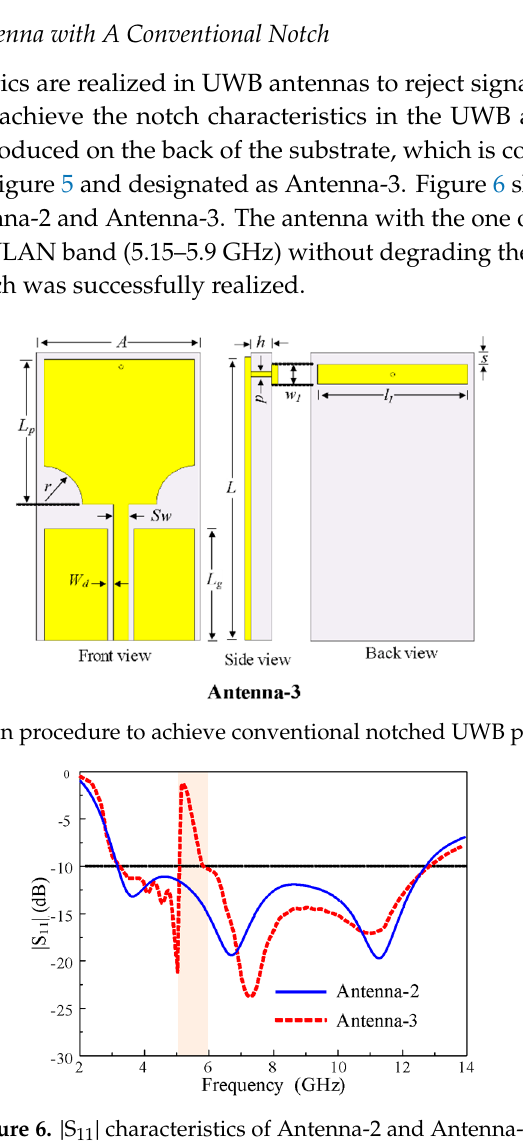
Figure 7. Characteristics of Antenna-2 and antenna design procedure to achieve conventional notched UWB patch antenna. Figure 8. |S 11 | characteristics of Antenna-3 and Antenna-4.